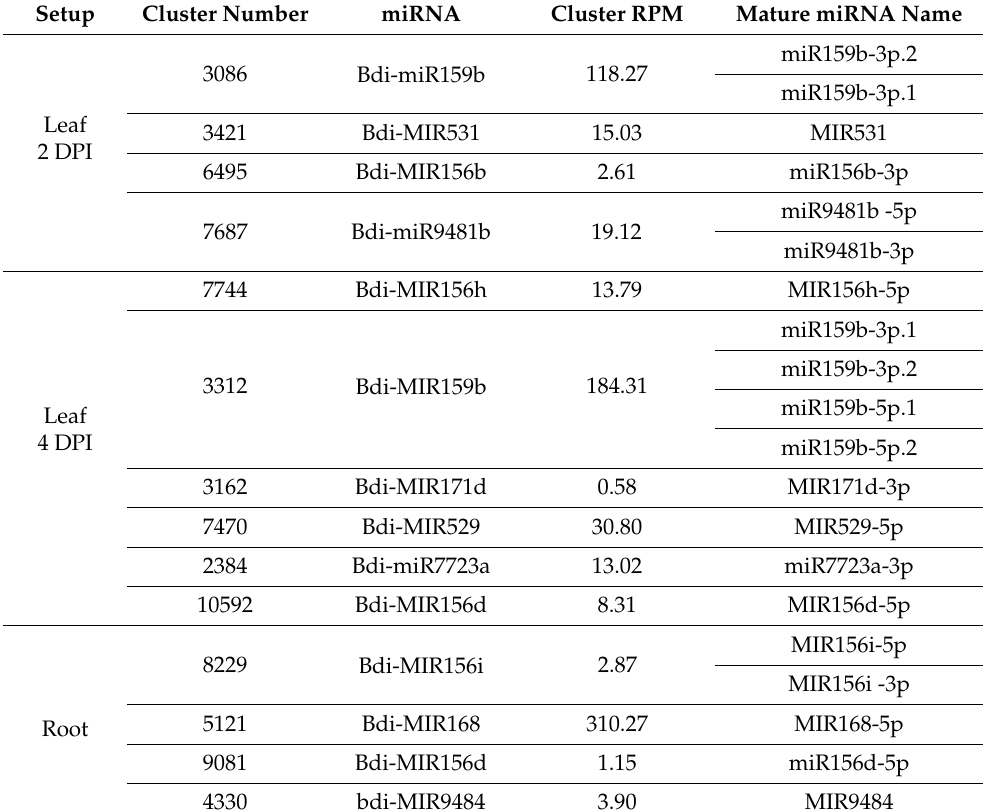
Table 4. B. distachyon miRNA